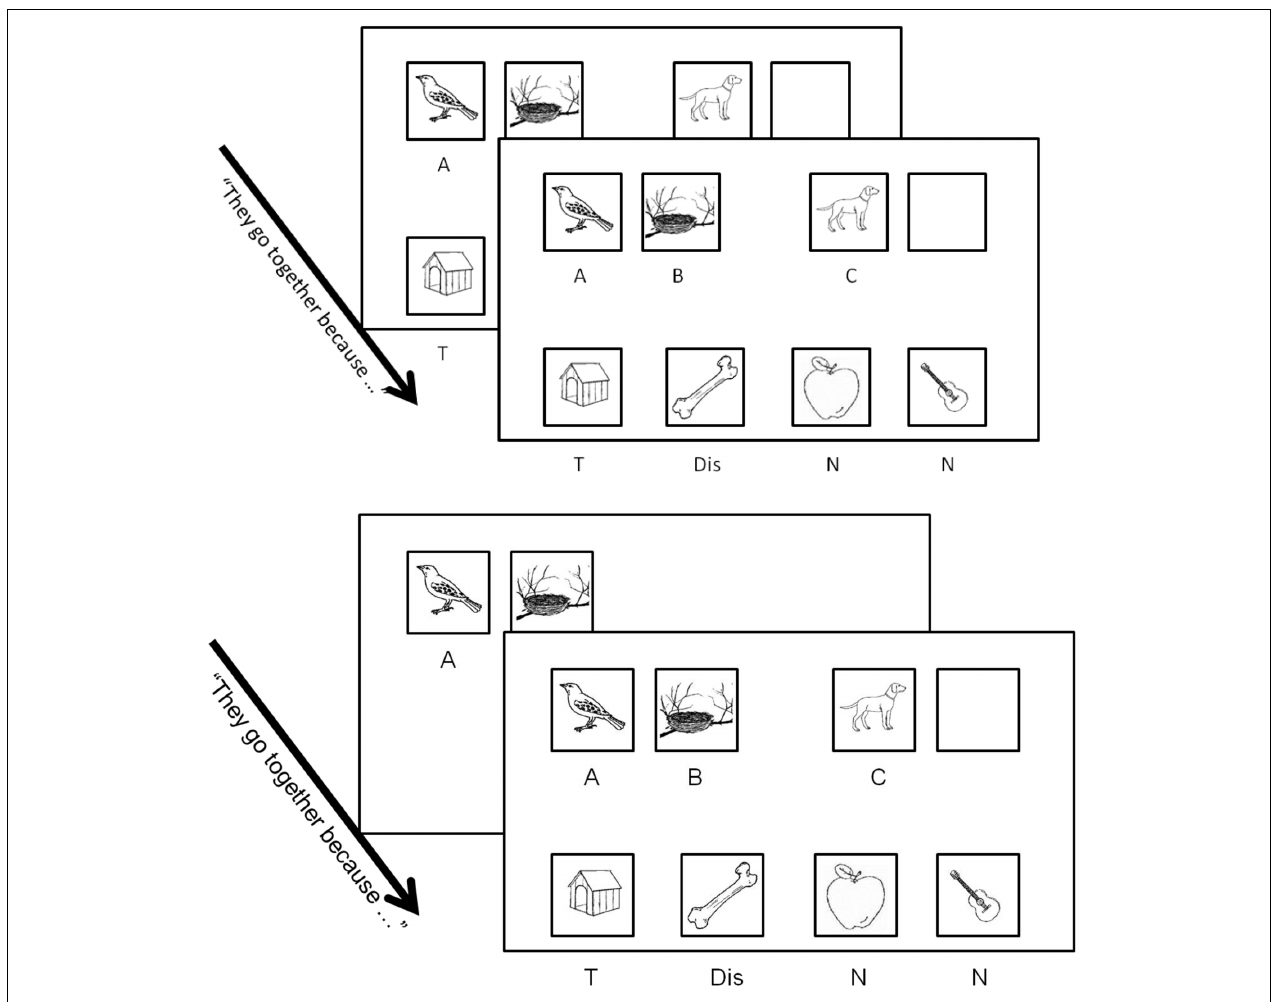
FIGURE 1 | Design of the Standard/Verbalization (upper) and A:B-first/Verbalization conditions (lower), (Experiment